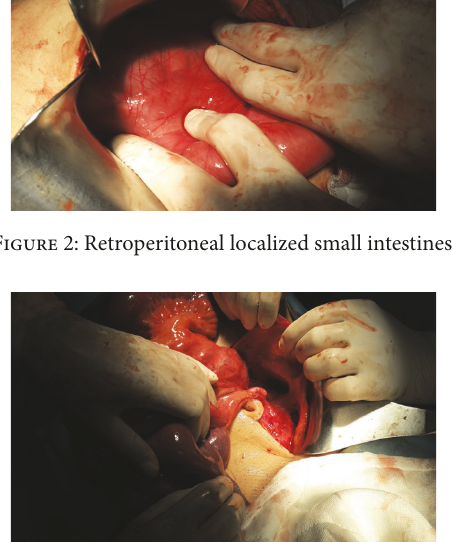
Figure 3: Opened peritoneal sheet.